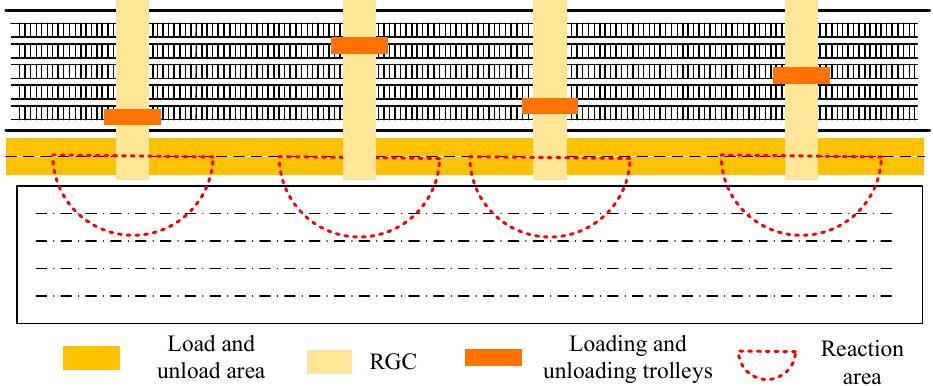
Figure 3. Layout of track gantry crane in railway yard